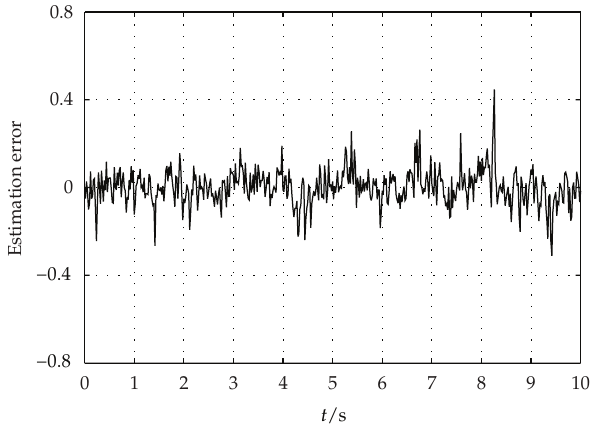
Figure 3: Estimation error (cid:24) z (cid:5) t (cid:6)